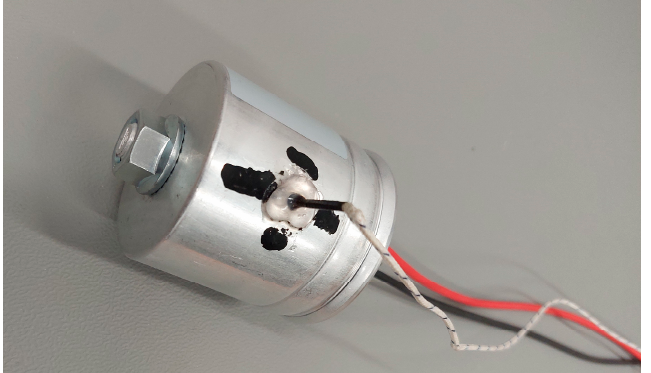
Figure 5. Place where the thermocouple was inserted into the capacitor case and the placement of the marker on the case.